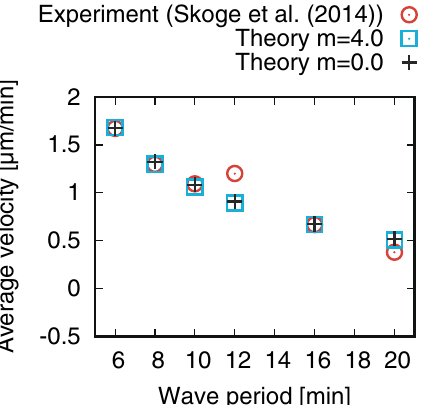
Figure 3. Comparison of the average velocity between the experimental 8 and theoretical values. Parameter values are ( m = 4.0 min ) α = 0.5 , β = 0.2 min , and χ 0 = 1639 ; and ( m = 0.0 min ) α = 0.5 , β = 0.6 min , and χ 0 = 663 . Reproduced from Skoge et al. PNAS 111 : 14448 (2014), all rights reserved.